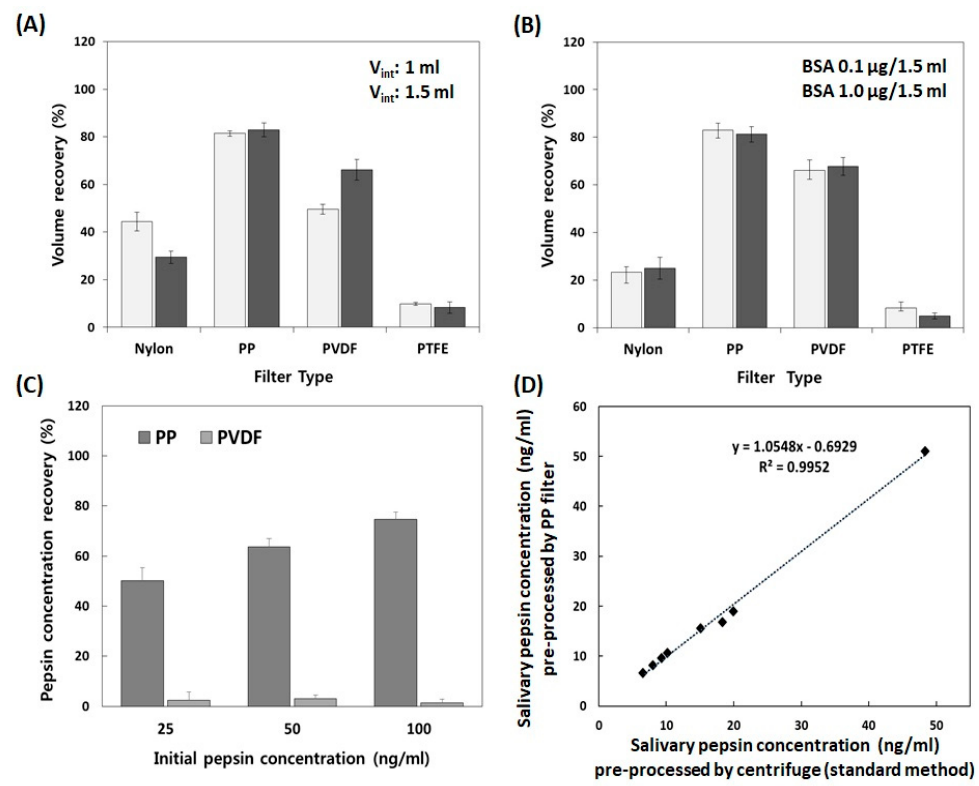
Figure 3. Comparison of the percent volume recovery from each syringe filter such as nylon, polypropylene (PP), polyvinyl difluoride (PVDF), and polytetrafluorethylene (PTFE), utilizing an artificial saliva solution ( A ) without and ( B ) with bovine serum albumin (BSA). ( C ) Shows the change in the concentration of pepsin after passing through a PP and PVDF filter, respectively. ( D ) Comparison of the concentration of pepsin in the saliva of laryngopharyngeal reflux (LPR) patients which is pre-processed with the PP filter and a centrifuge (as a standard method). The pepsin levels were measured utilizing a pepsin enzyme-linked immunosorbent assay (ELISA) assay.